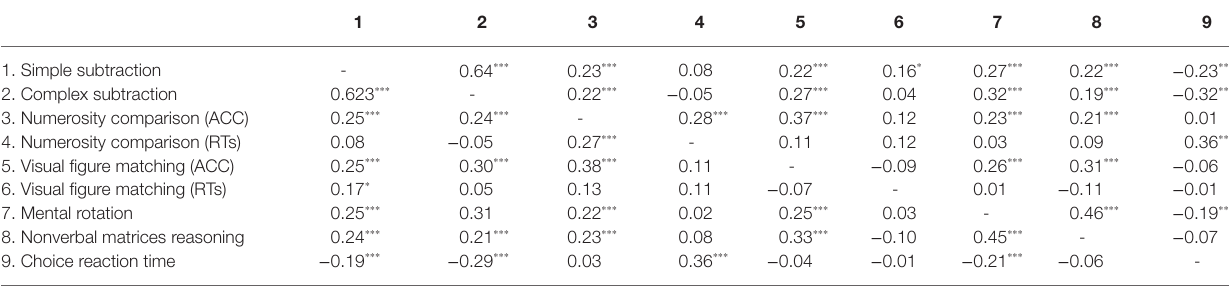
TABLE 2 | Correlation and partial correlation after controlling for age and gender differences for all tasks.